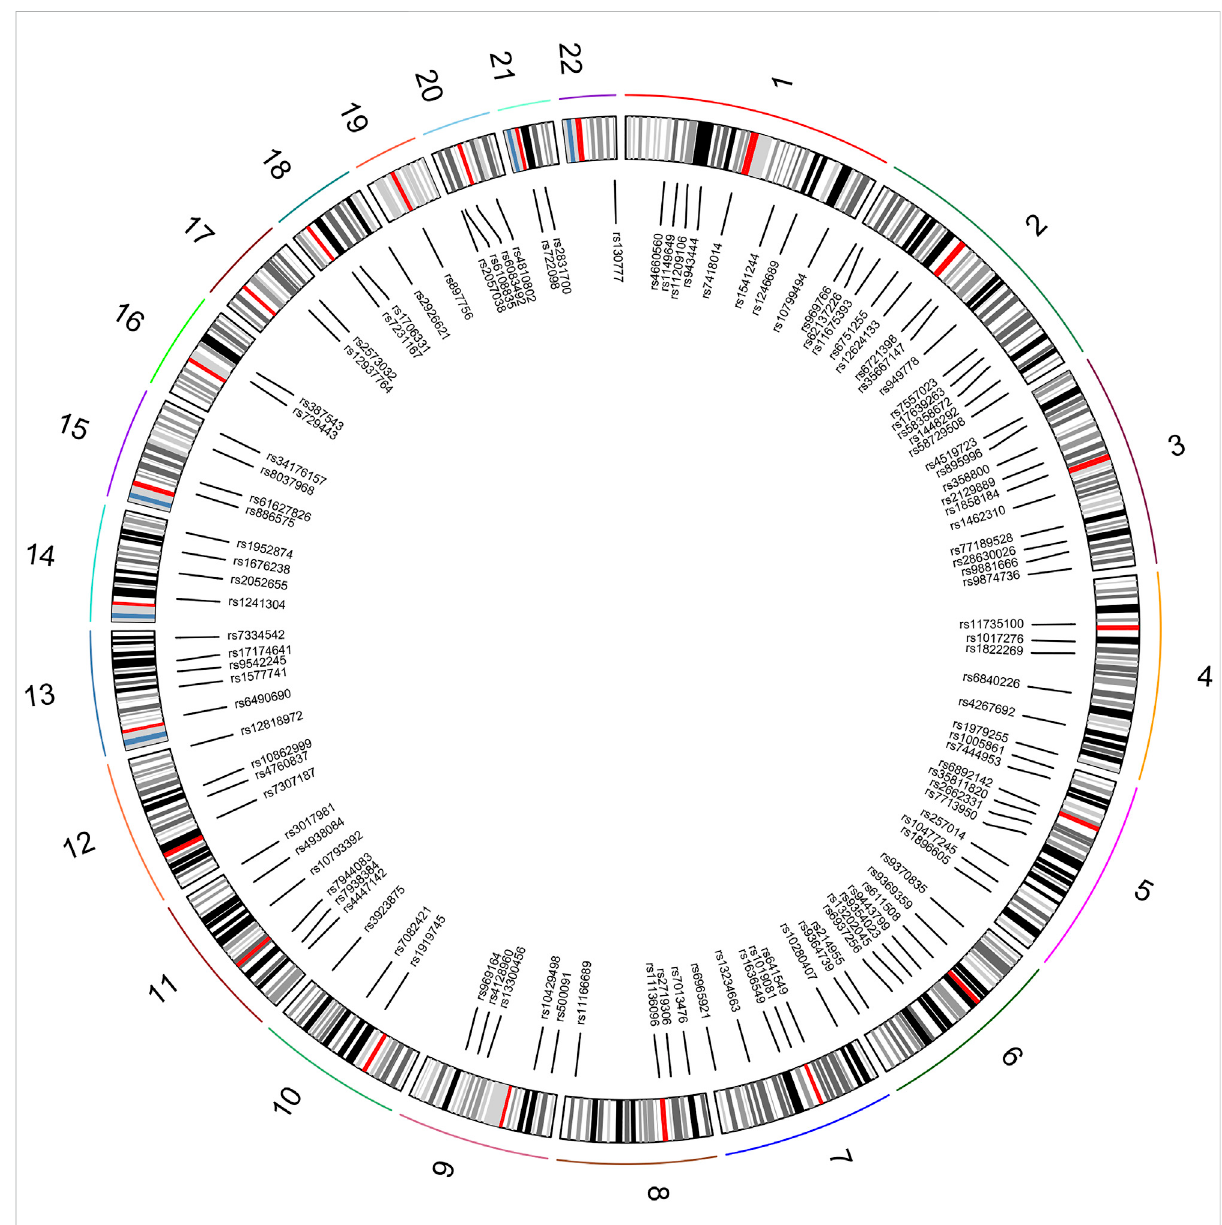
FIGURE 1 Distributions of 111 II-SNPs on different